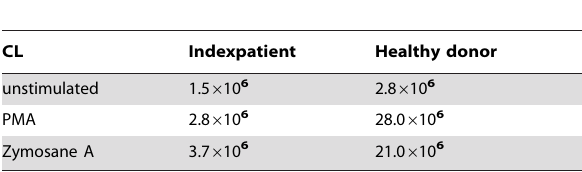
Table 2. Residual ROS (superoxide) production by 10 5 neutrophils.